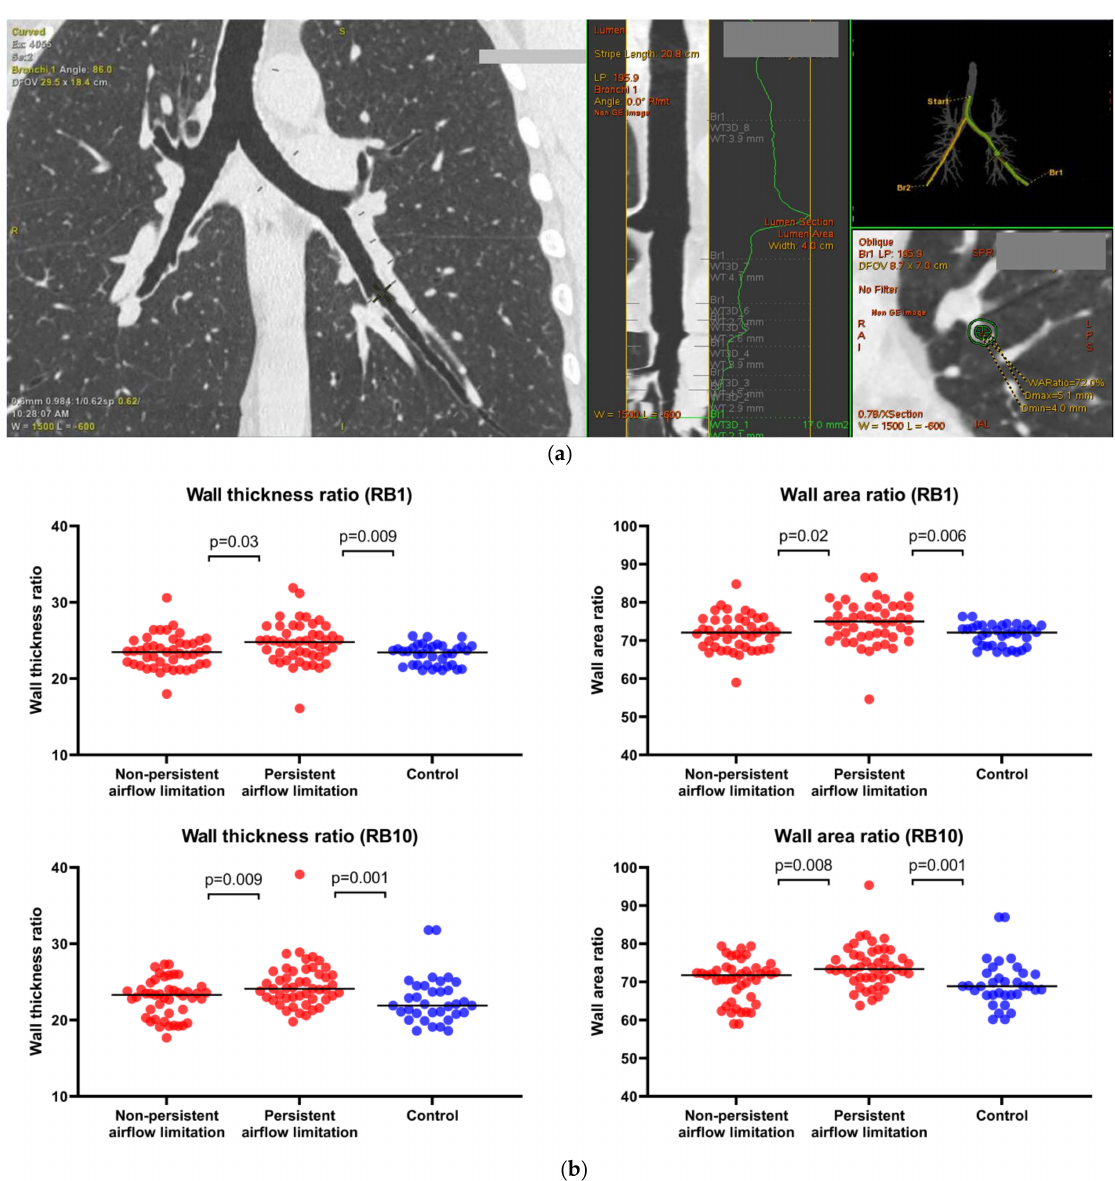
Figure 4. Computed tomography airway geometry parameters in asthma patients with persistent and non-persistent airflow limitation, and controls. ( a ) Automatic evaluation of airway geometry parameters in lung computed tomography imaging. After identifying the studied bronchus, the operator placed a seed point in the airway lumen (left side), while the software automatically quantified airway geometry parameters, including lumen and airway diameters, wall thickness, lumen and wall area (bottom right side), and calculated wall thickness and wall area ratios. ( b ) Wall thickness ratio (WTR) and wall area ratio (WAR) of the right upper lobe apical segmental bronchus (RB1) (top) and the right lower lobe basal posterior bronchus (RB10) (bottom); n = 45 non-persistent airflow limitation patients, n = 47 persistent airway obstruction patients, and n = 36 control. Statistics: one-way covariance analysis (ANCOVA) adjusted for age, sex, and body mass